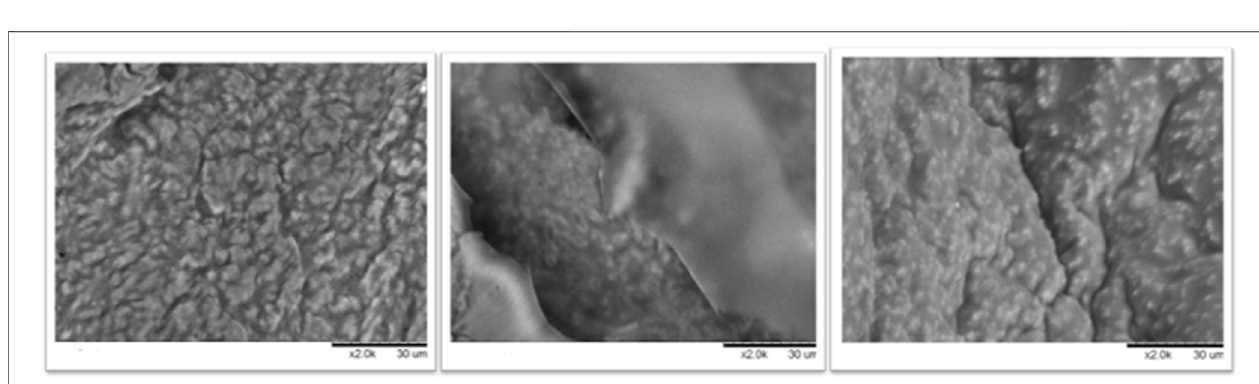
FIGURE 7 | Combi-CLEAs studied by SEM: ethanol at 90% in the left, acetone at 90% in the middle, and PEG at 80% in the right.